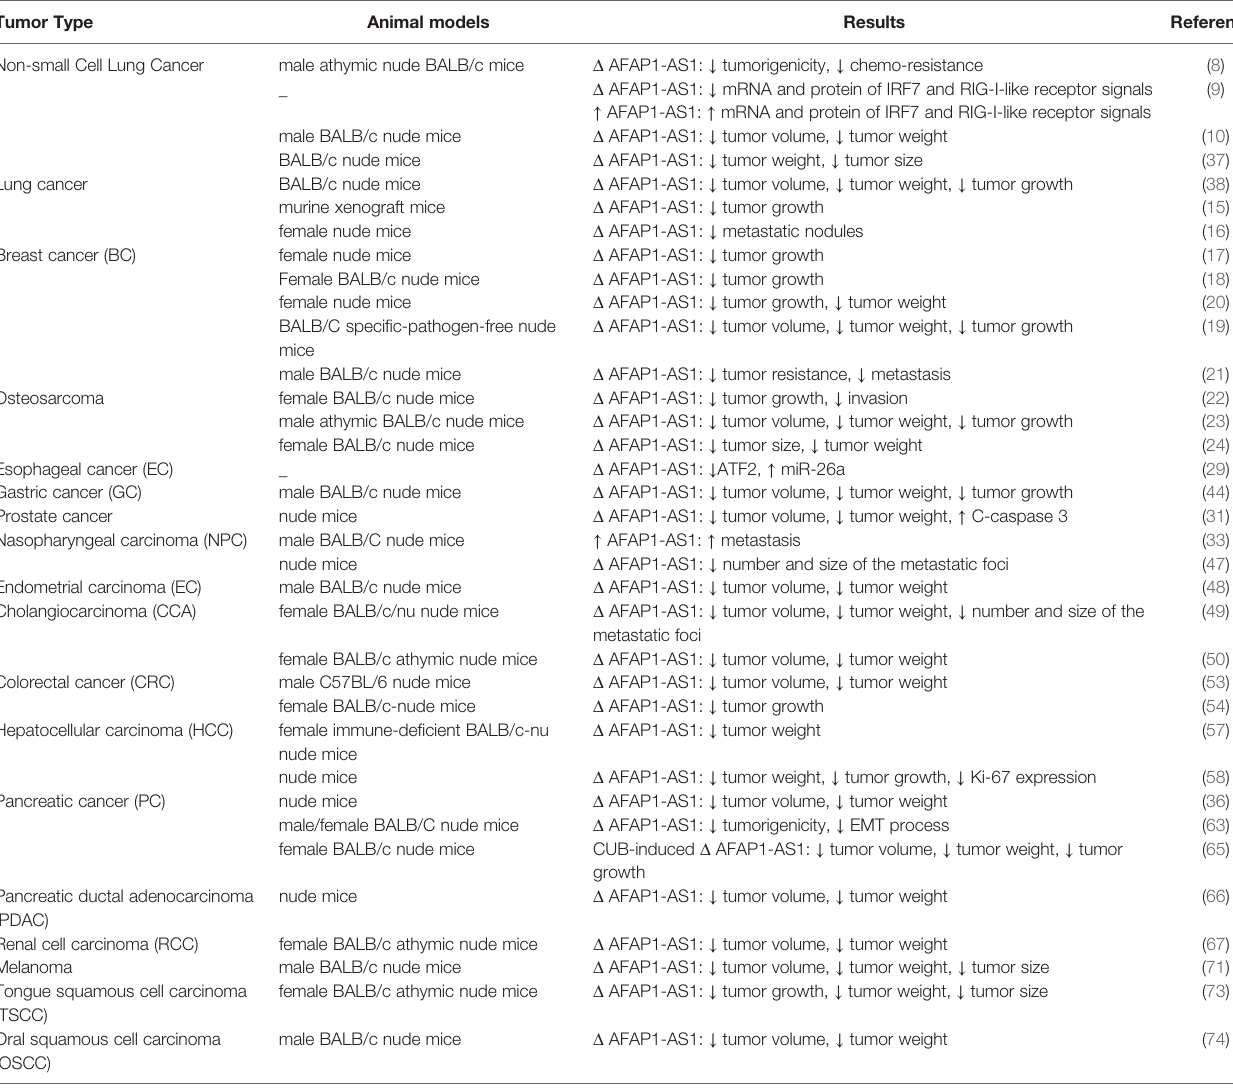
TABLE 2 | Outlines of studies which tested function of AFAP1-AS1 in